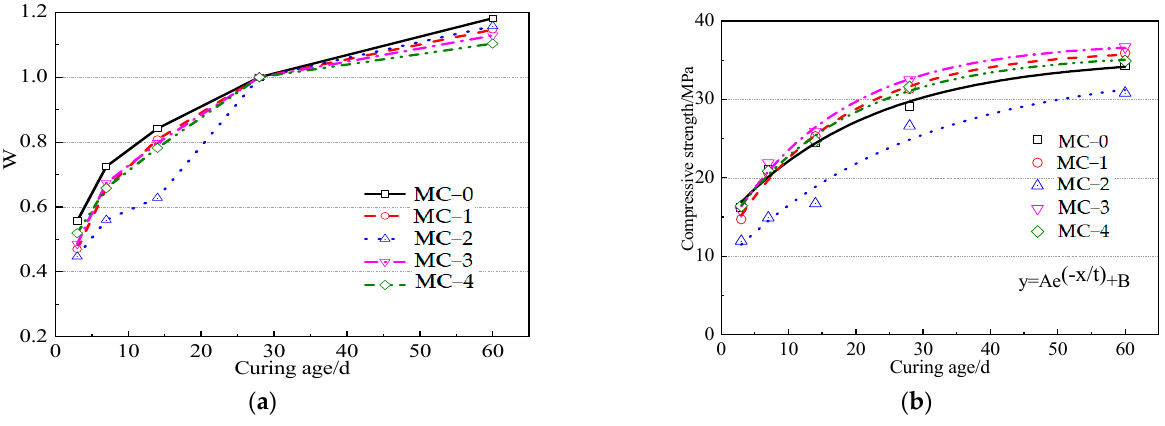
Figure 7. Relationship between the flexural strength of NCM and age. ( a ) Z; ( b ) R f . The relationship between NCM compressive strength, the28 days compressive strength ratio W and the curing age, and the relationship between compressive strength and age are shown in Figure 8. Figure 8a shows that the compressive strength of NCM in each group increases with age, and the strength increases rapidly before 7 days. The increase in strength ratiosfrom7 days to 28 days are 72.5%, 65.8%, 56.0%, 67.4%, and 65.8%, respectively. Figure 8b shows that the compressive strength of NCM increases exponentially with age, and the growth rate of NCM compressive strength decreases with the increase in age. The growth rate of early compressive strength of NCM is NMK > ordinary cement mortar ≥ NMA. After 14 days, the growth rate is the same. Therefore, the most substantial growth rate of the compressive strength of NCM gradually slows down after 7 days. In the early days,(especially in the first 7 days), the hydration reaction of NCM is rapid, and NMK clay particles significantly affect the improvement in the performance of cement mortar. This is a crucial stage for the development of the compressive strength of NCM; therefore, sufficient attention should be paid to engineering this stage.